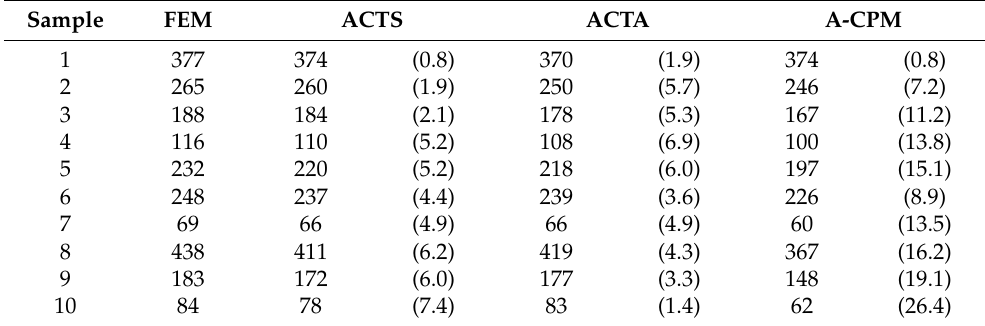
Table 2. The von Mises stress at the center of the sample in FEM, ACTS, ACTA, and A-CPM models, in the units of MPa. The numbers in the parentheses are the calculated percentage errors.